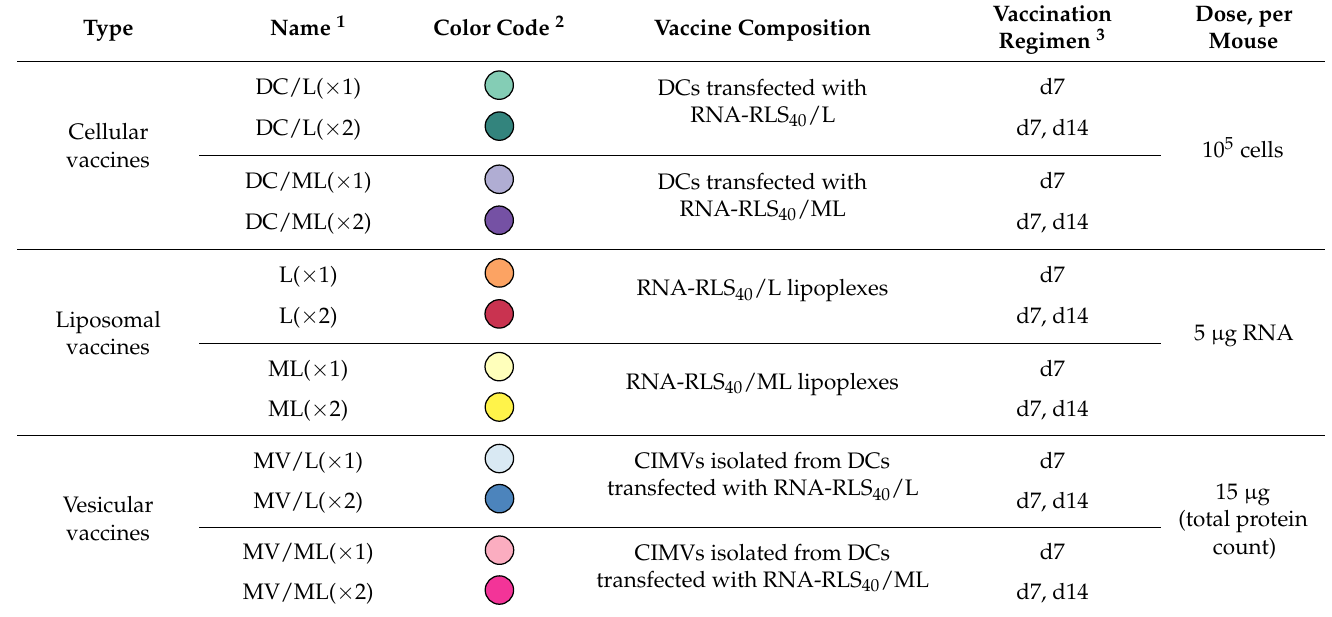
RLS 40 -bearing Table 2. Vaccine types and composition, list of experimental groups and regimens of vaccination of Table 2. Vaccine types and composition, list of experimental groups and regimens of vaccination of RLS 40 -bearing mice. RLS 40 -bearing mice. Table 2. Vaccine types and composition, list of experimental groups and regimens of vaccination of Table 2. Vaccine types and composition, list of experimental groups and regimens of vaccination of RLS 40 -bearing mice. RLS 40 -bearing mice. Table 2. Vaccine types and composition, list of experimental groups and regimens of vaccination of Table 2. Vaccine types and composition, list of experimental groups and regimens of vaccination of RLS 40 -bearing mice. RLS 40 -bearing mice. Table 2. Vaccine types and composition, list of experimental groups and regimens of vaccination of Table 2. Vaccine types and composition, list of experimental groups and regimens of vaccination of Table 2. Vaccine types and composition, list of experimental groups and regimens of vaccination of RLS 40 -bearing mice. RLS 40 -bearing mice. RLS 40 -bearing mice.